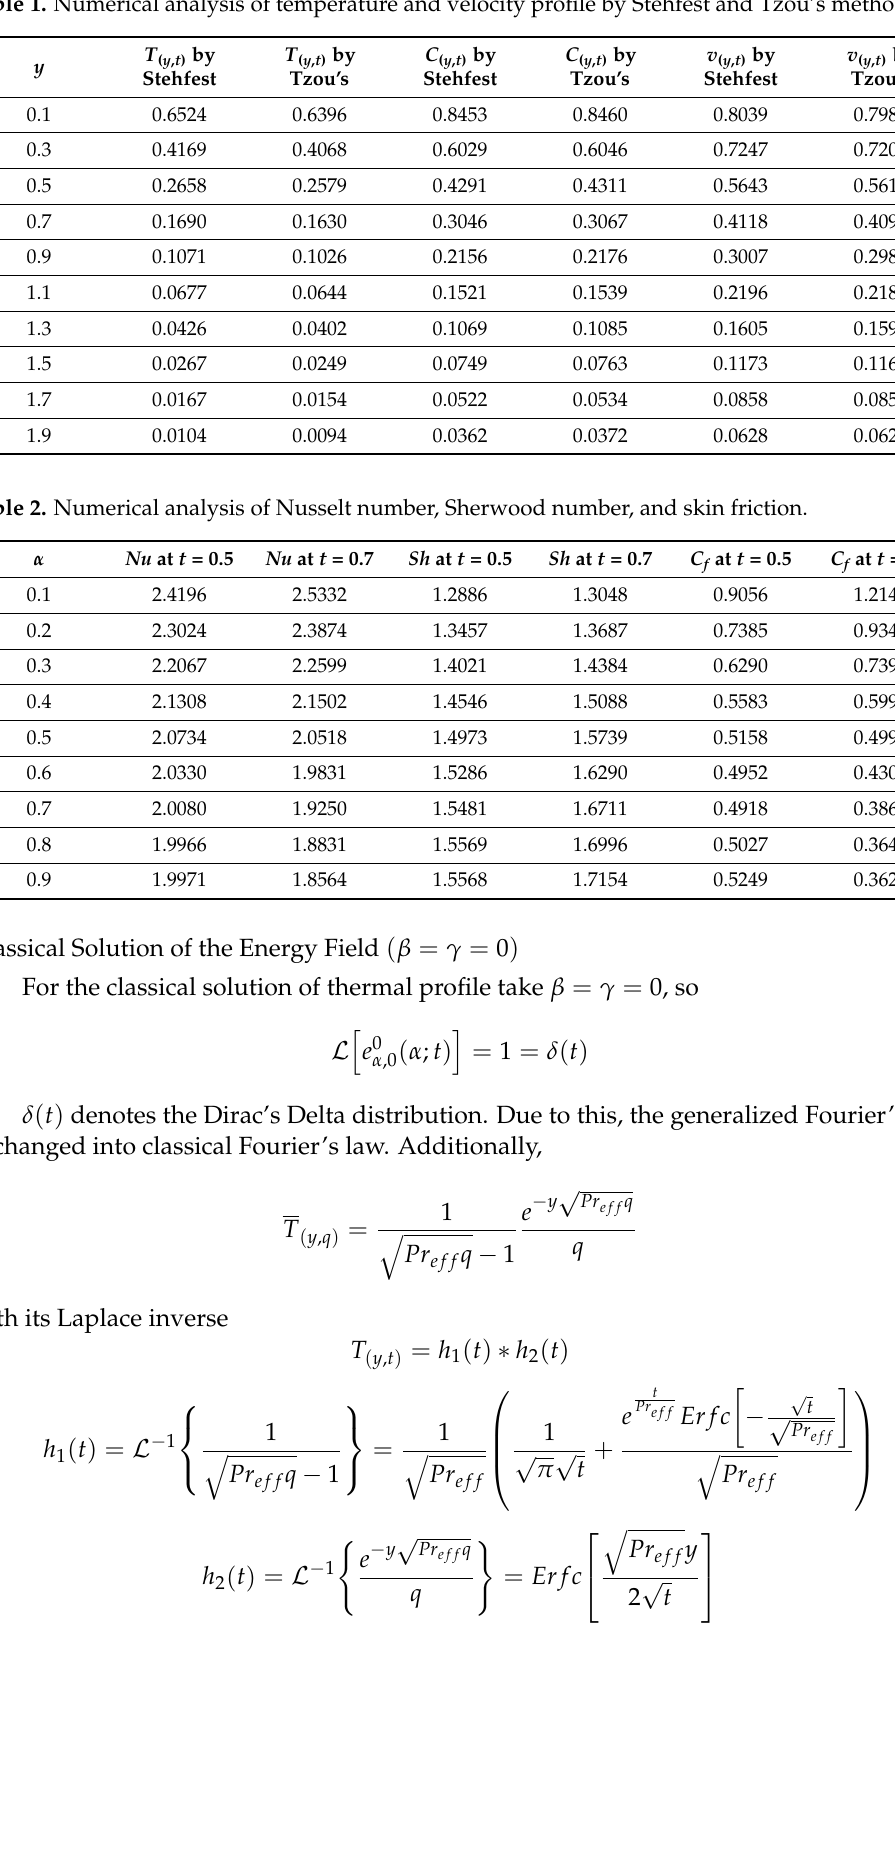
Table 1. Numerical analysis of temperature and velocity profile by Stehfest and Tzou’s method.